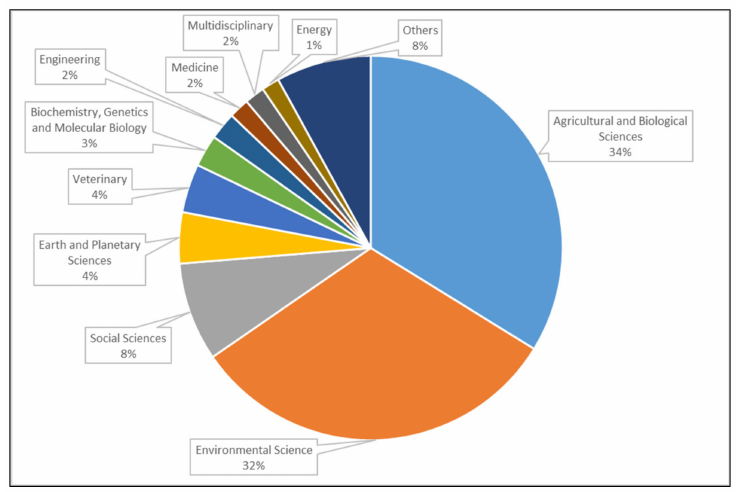
Figure 3. Main fields of study to which the documents subject to the bibliometric analysis are related. Only the fields where more than 60 documents have been produced are